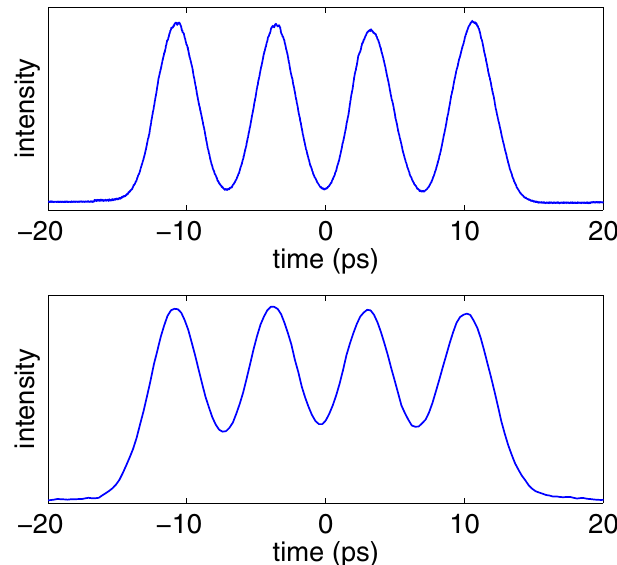
FIG. 6. (Color) Laser pulse (top) and electron bunch (bottom) temporal profile measurement after two shaping crystals.